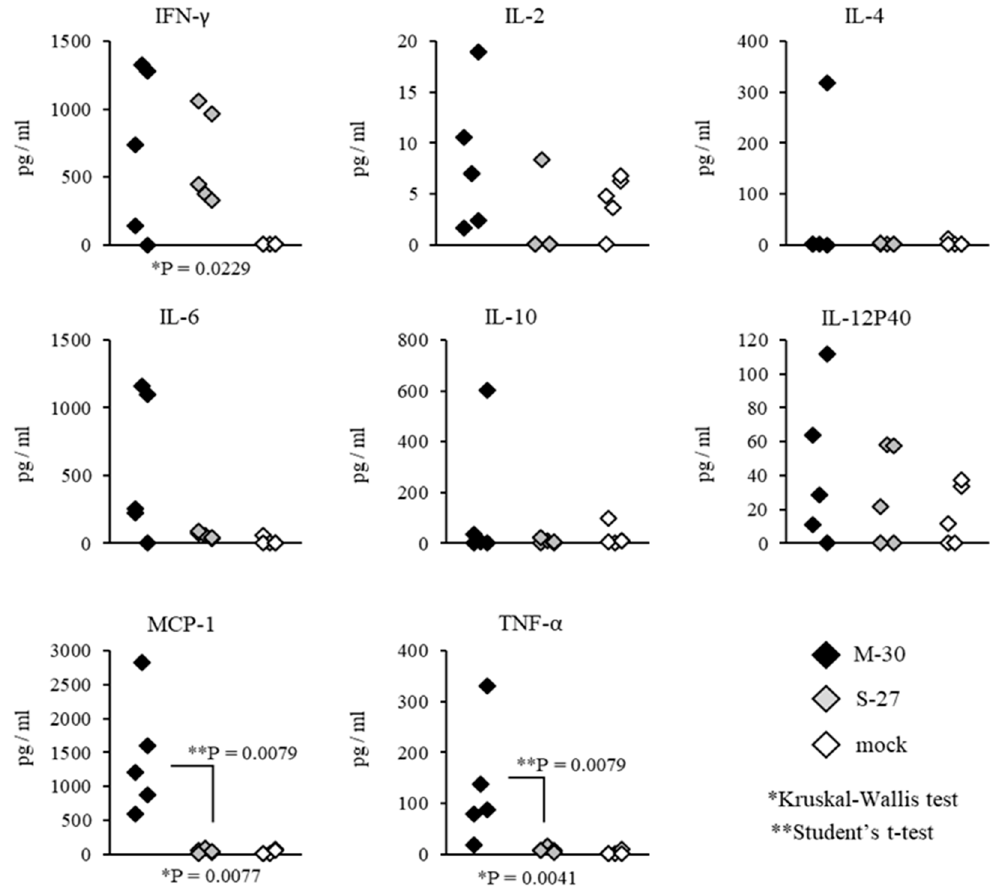
Figure 8. Serum cytokine levels of IFN- γ , IL-2, IL-4, IL-6, IL-10, IL-12P40, MCP-1 and TNF- α were determined by multiplex magnetic bead assay in A129 mice at 3 days after subcutaneous infection with 10 2 PFU of M-30 and S-27 CHIKV strains. The asterisks show significant differences by the Kruskal–Wallis test (*) and by the Mann–Whitney U-test (**), P < 0.05. On the other hand, in AG129 mice, the levels of MCP-1 ( p = 0.0159) and TNF- α ( p = 0.0079) were significantly increased in S-27-infected mice compared with M-30-infected and mock-infected mice between M-30- and S-27-infected mice (Figures 8 and